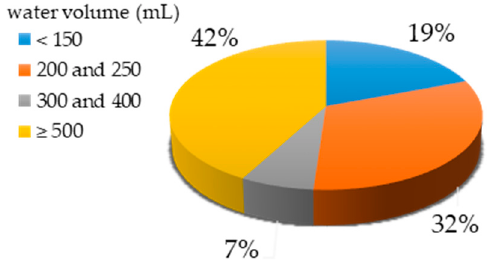
Figure 2. Percentage of studies according to water volume.